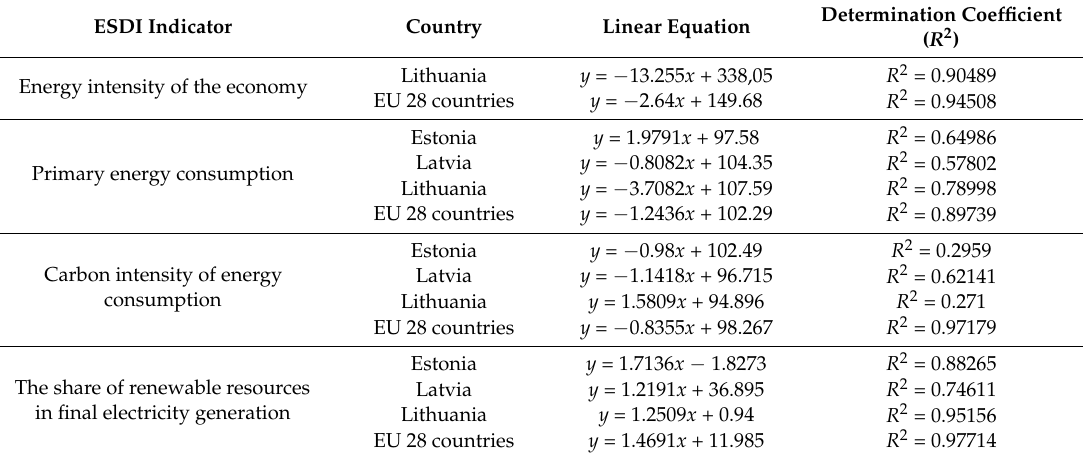
Table 8. Linear equations of energy sustainability temporal dynamics and their statistical